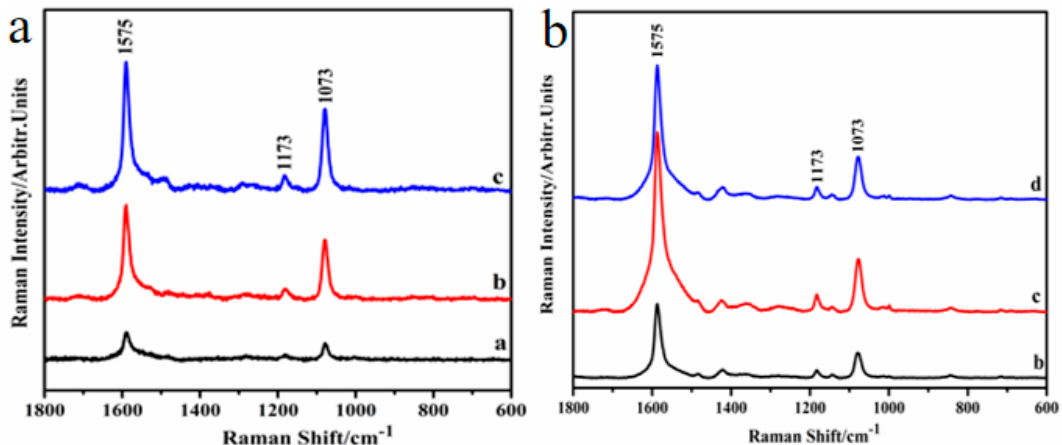
Figure 5. ( a , b ) The surface-enhanced Raman scattering (SERS) spectrum of 4-mercaptobenzoic acid (4-MBA) for the Au nanohoneycomb and SiO 2 − Ag nanocap arrays, which correspond to Figures 2a–c and 4b–d, respectively. Reproduced with permission from [38] American Chemical Society, 2019; Reproduced with permission from [9] American Chemical Society, 2014. Nanomaterials 2019 , 9 , x FOR PEER REVIEW